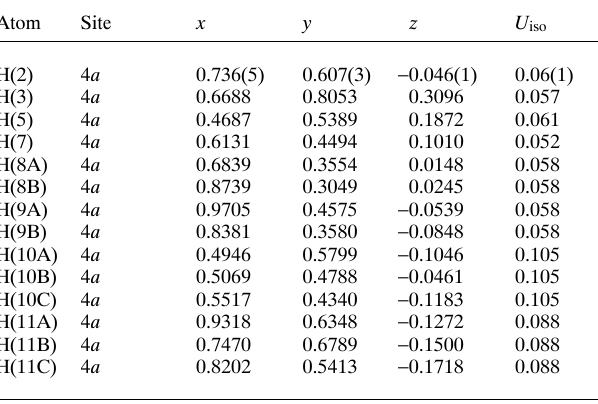
Table 2. A tomic coordin a tes a nd displ a cement p a r a meters (in Å 2 )